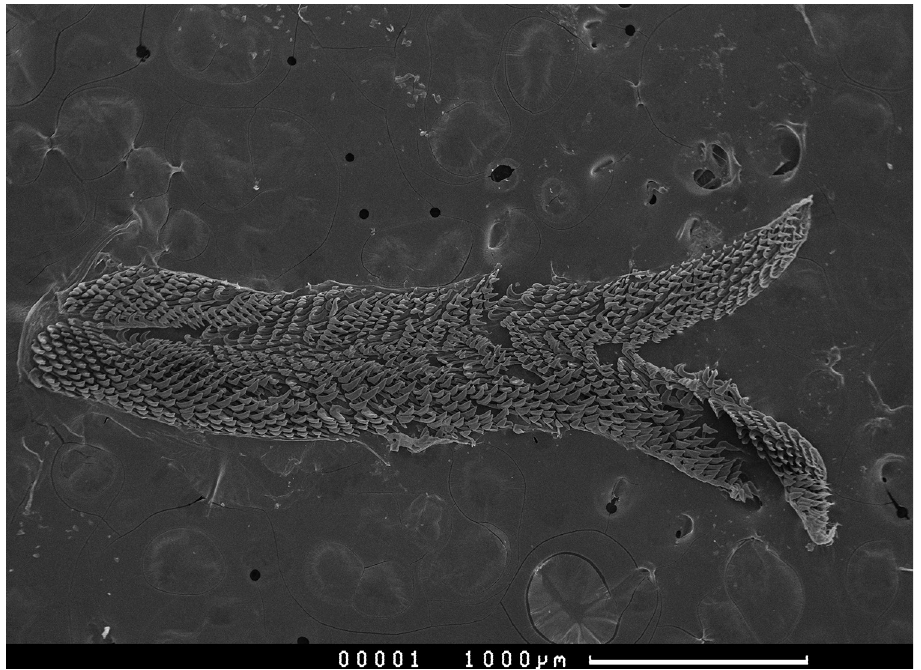
Figure 11. Paradoris hypocrita sp. nov., SEM of whole radula of paratype SMF